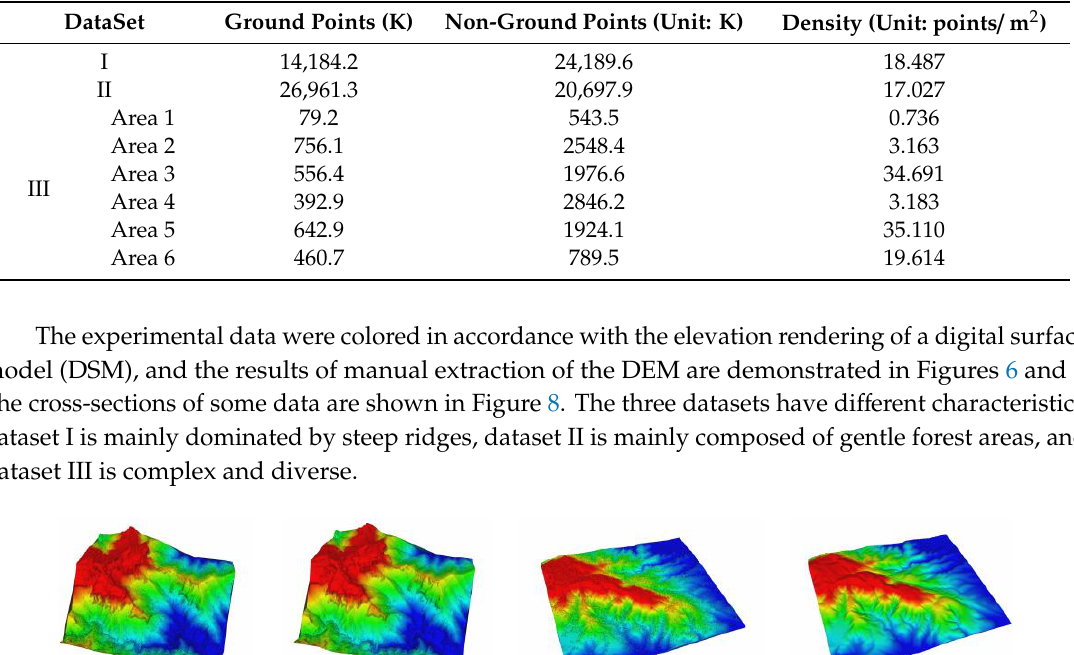
Table 1. Three datasets for our experiments.